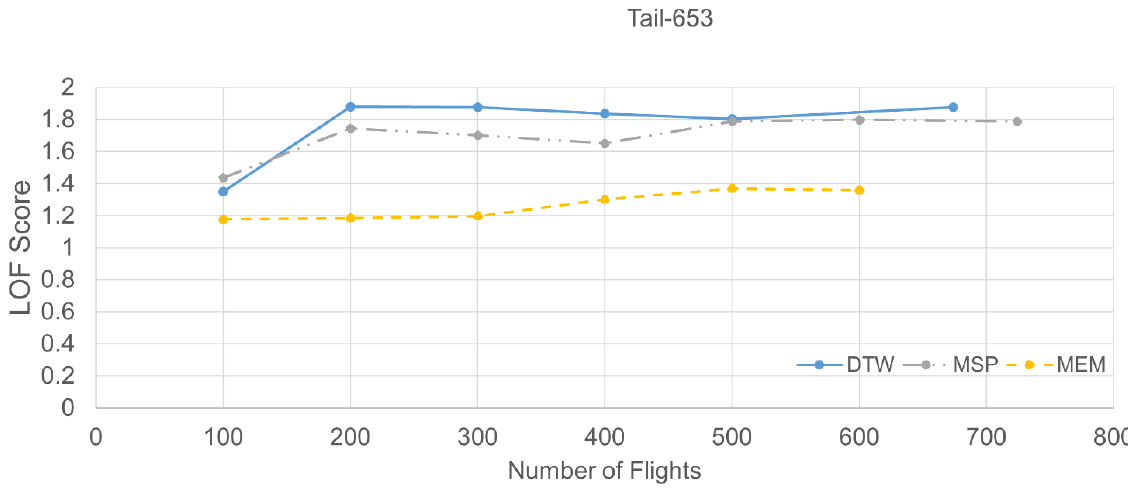
Figure 9. LOF score analysis for three airports.